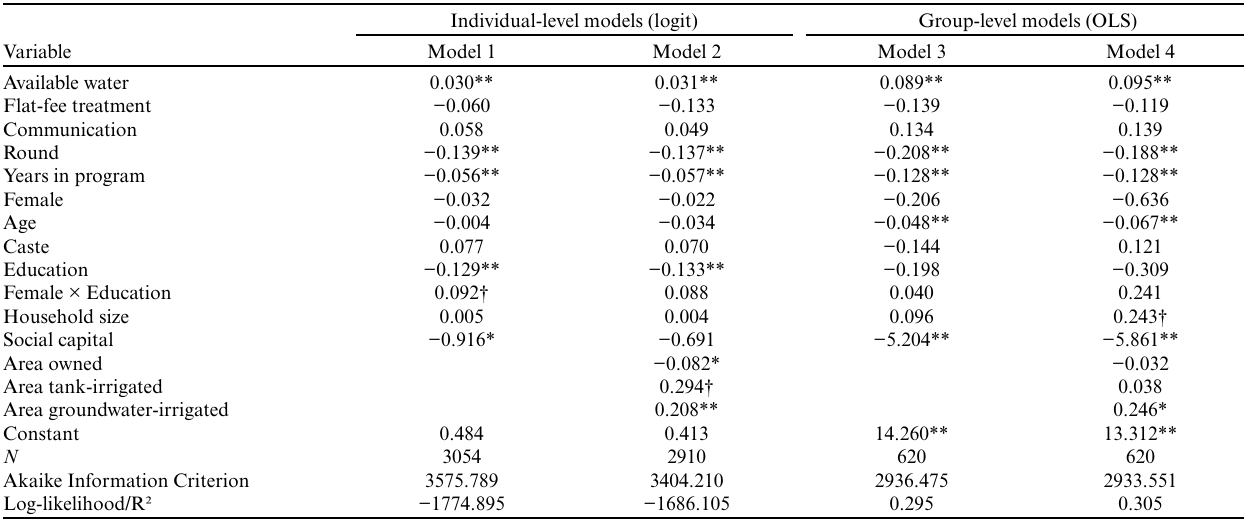
Table 2. Individual- and group-level models for choice of water-consumptive